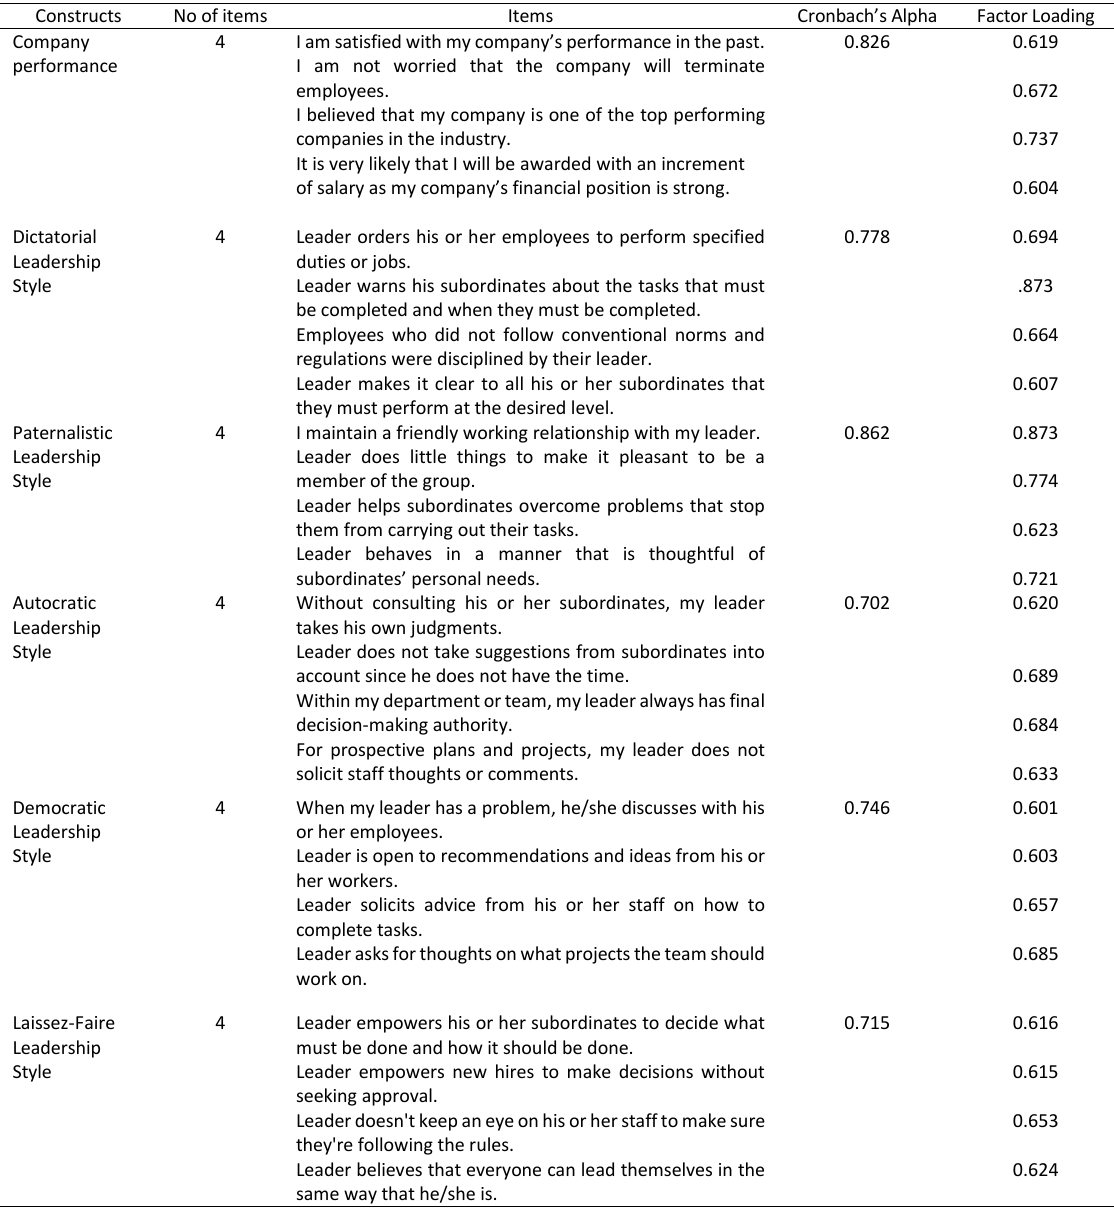
Table 1. Reliability and factor loading statistics results